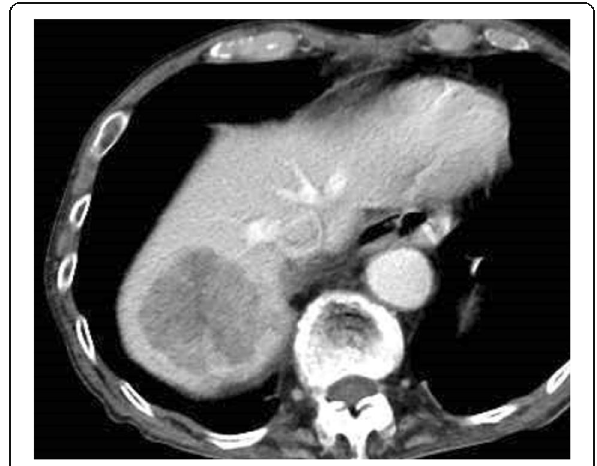
Fig. 5 Abdominal computed tomography (CT) findings 2 months after surgery. A liver tumor was identified with enhanced delivery at the edges implying high external density and low intracellular density